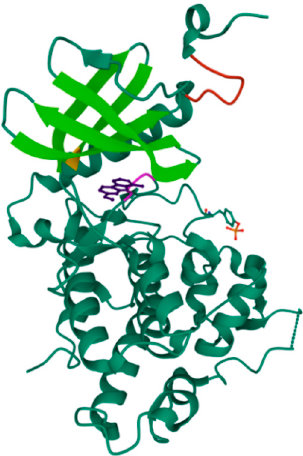
Figure 5. Stereo pair secondary structure cartoon of human DYRK1A in complex with harmine (4) (purple) PDB ID: 3ANR [51]. Five antiparallel β -strands at the N -terminal lobe are depicted in light green; the DH box is depicted in red; Phe238 is depicted in orange; the DFG pocket is depicted in magenta.